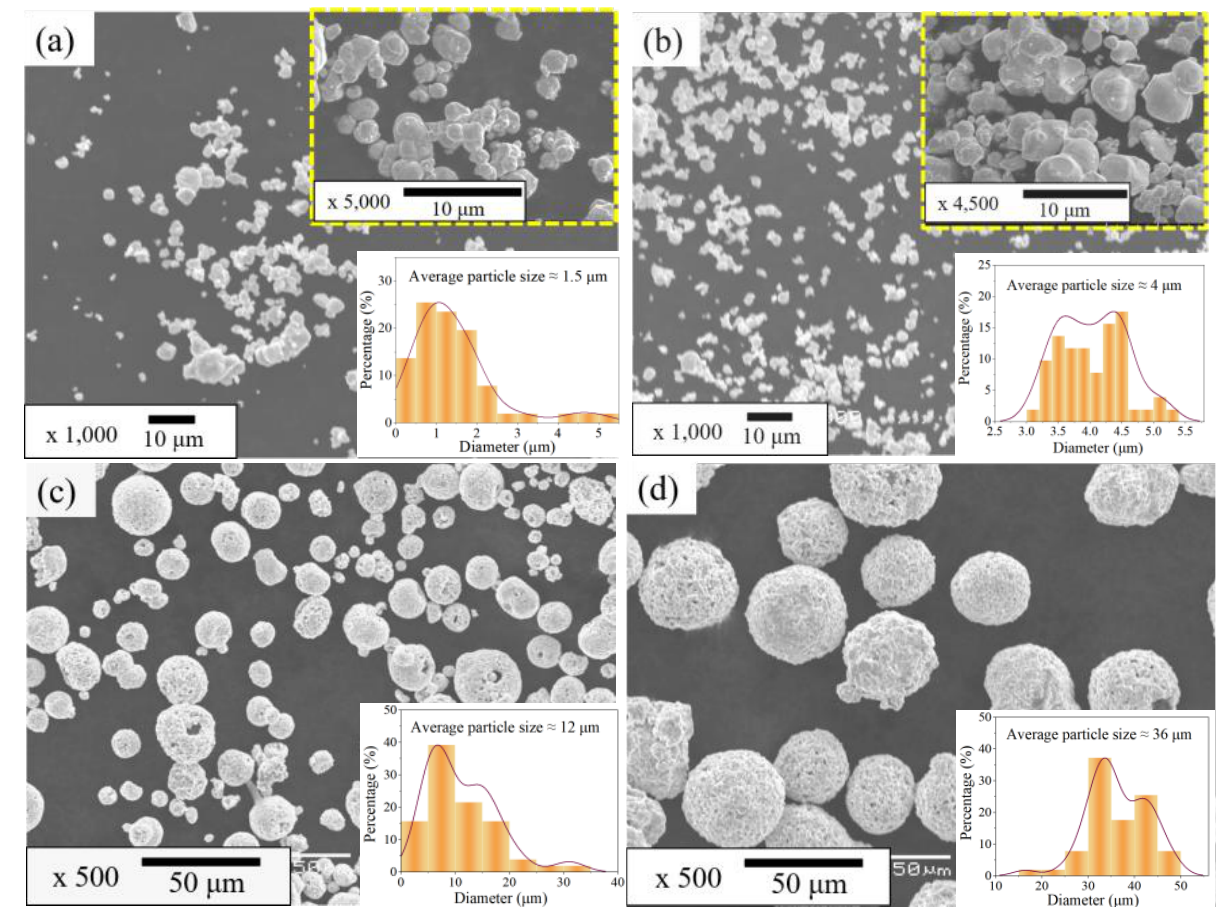
Figure 2. SEM images of WC particles of different sizes: WC particles with an average particle size of ( a ) 1.5 µ m; ( b ) 4 µ m; ( c ) 12 µ m; ( d ) 36 µ